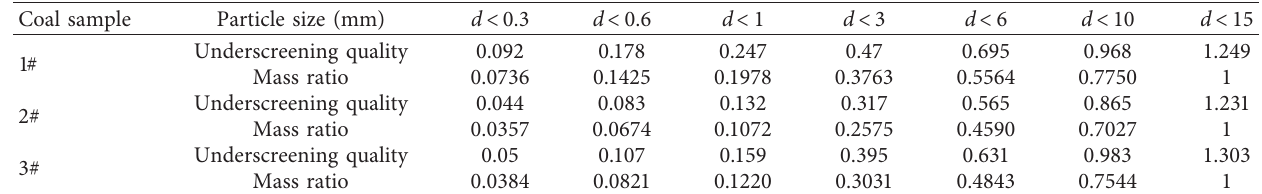
Table 1: The initial mass content of each grain group.